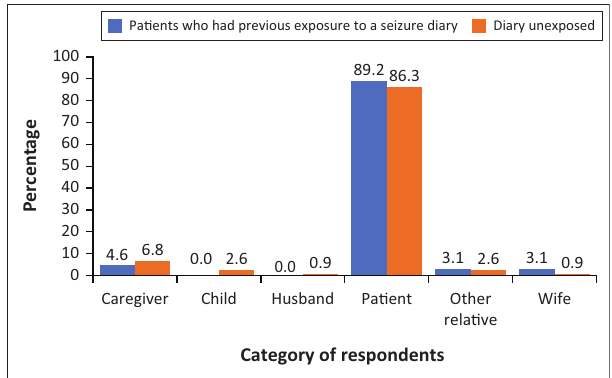
FIGURE 1: Persons completing the TABLE 2: Disease characteristics. Variable